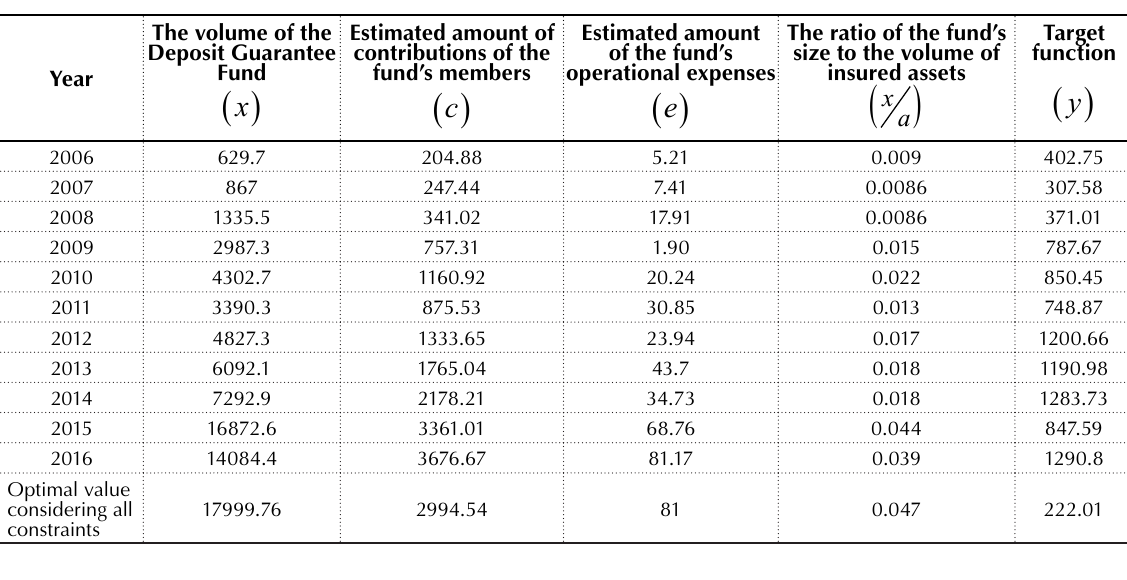
Table 5. The results of testing of the scientific and methodical approach to optimizing the volume of the Deposit Guarantee Fund, mln.